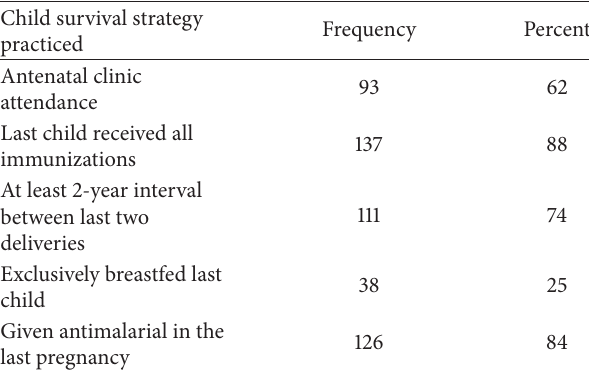
Table 5: Practice of child survival strategies in the last pregnancy and